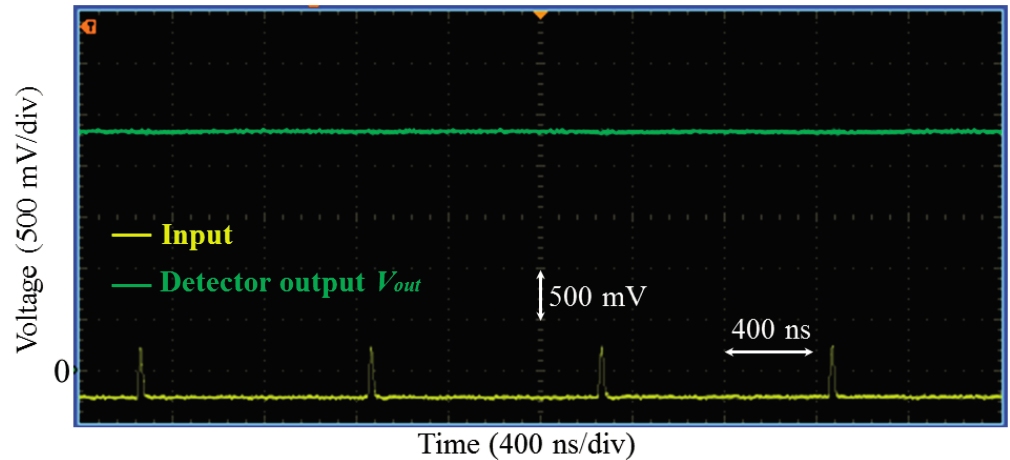
Figure 9. Peak detection of sharp pulses using the developed detector with R G = 10 k Ω . The pulse duration was less than 20 ns and the amplitude was about 225 mV. The repetition time of the pulse was of 1